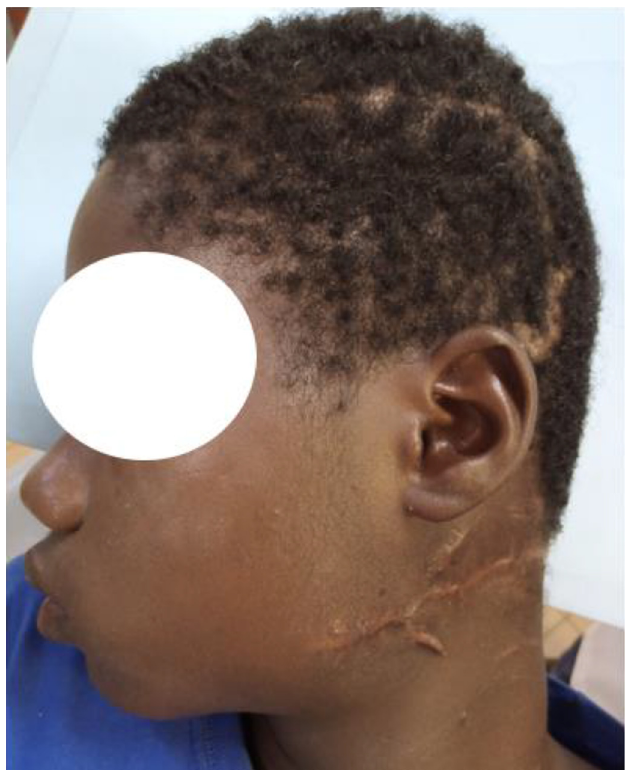
Fig. 6. Result at one month, good healing with discreet unsightly